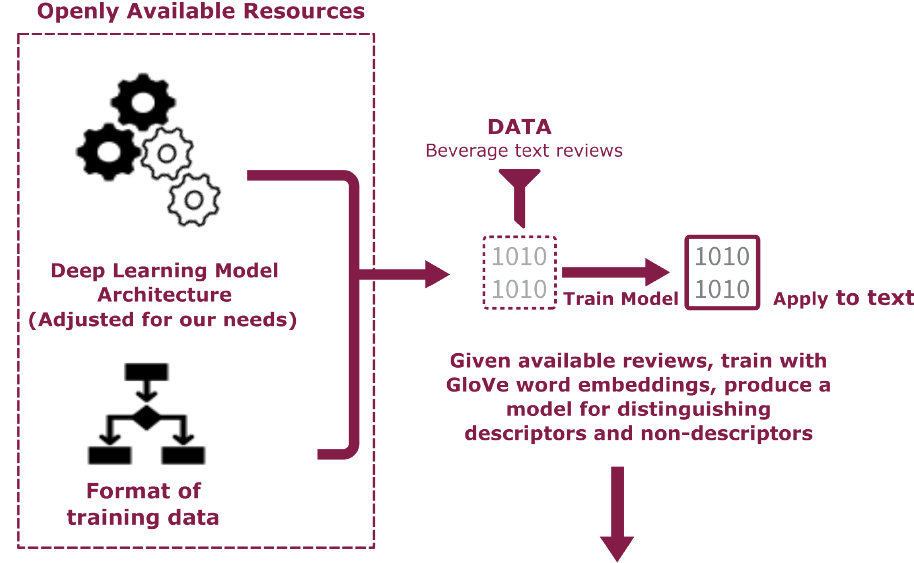
Figure 7 : Descriptor identification pipeline overview along with resources that were developed. The words in the last step highlighted in orange are the words identified as